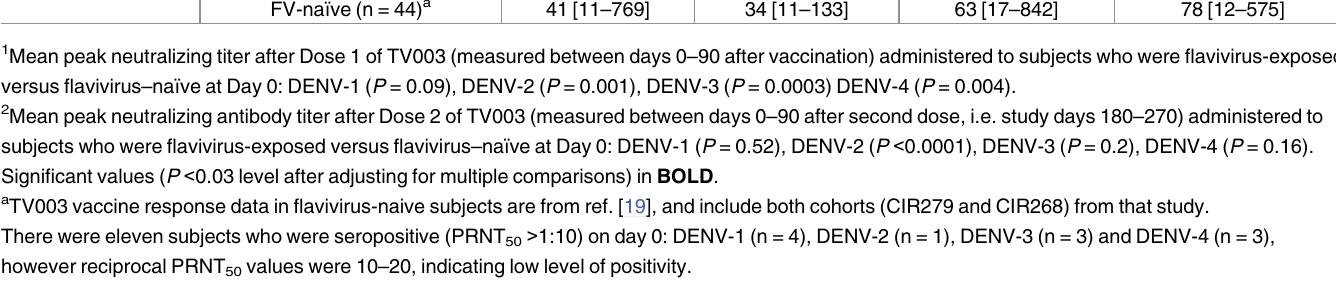
Table 3. Mean peak neutralizing antibody titers to TV003 in subjects who were flavivirus-experienced or -na ï ve a prior to vaccination. Reciprocal geometric mean titer [range] DENV-1 DENV-2 DENV-3